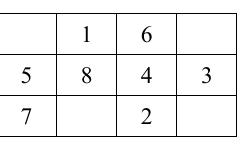
Fig. 1. A sample multi-line facility